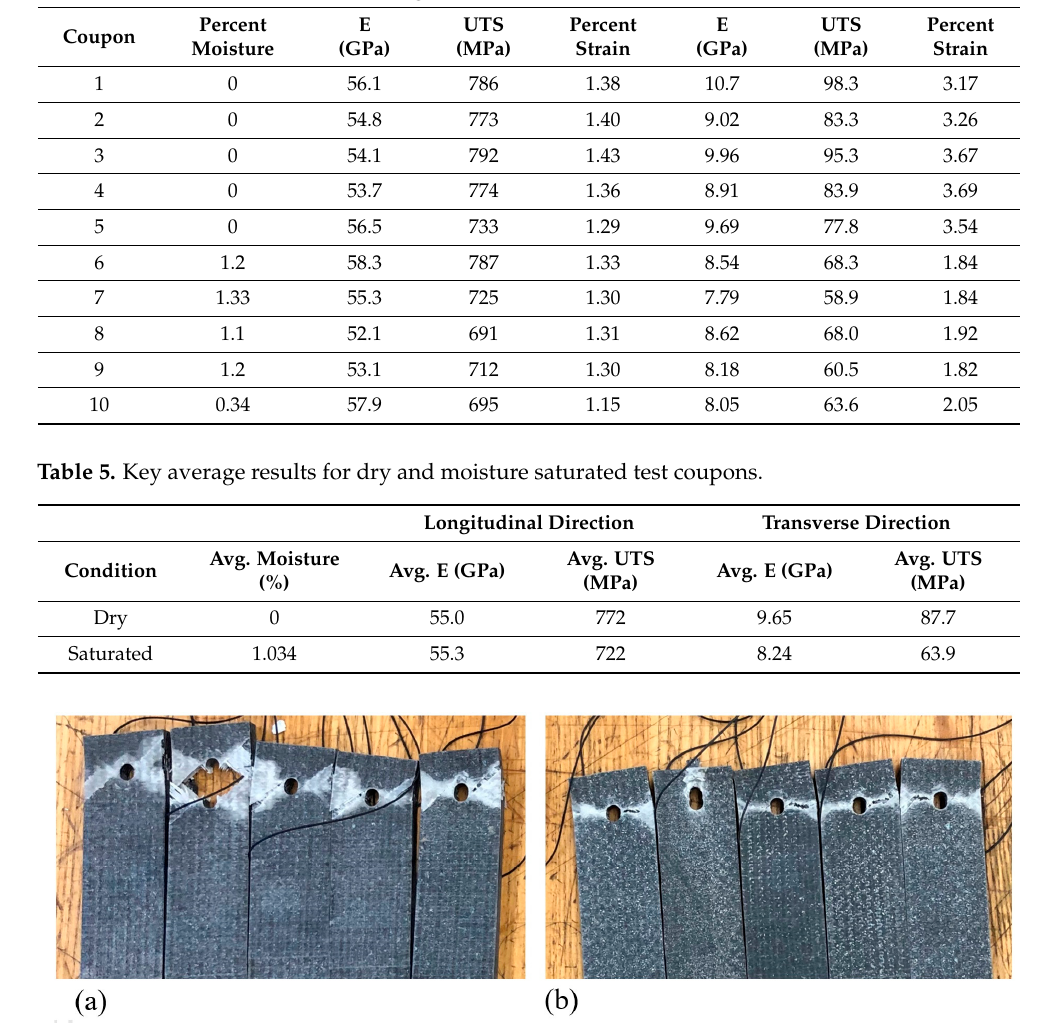
Figure 5. ( a ) Dry coupons after longitudinal tensile tests. ( b ) Saturated coupons after longitudinal tests.